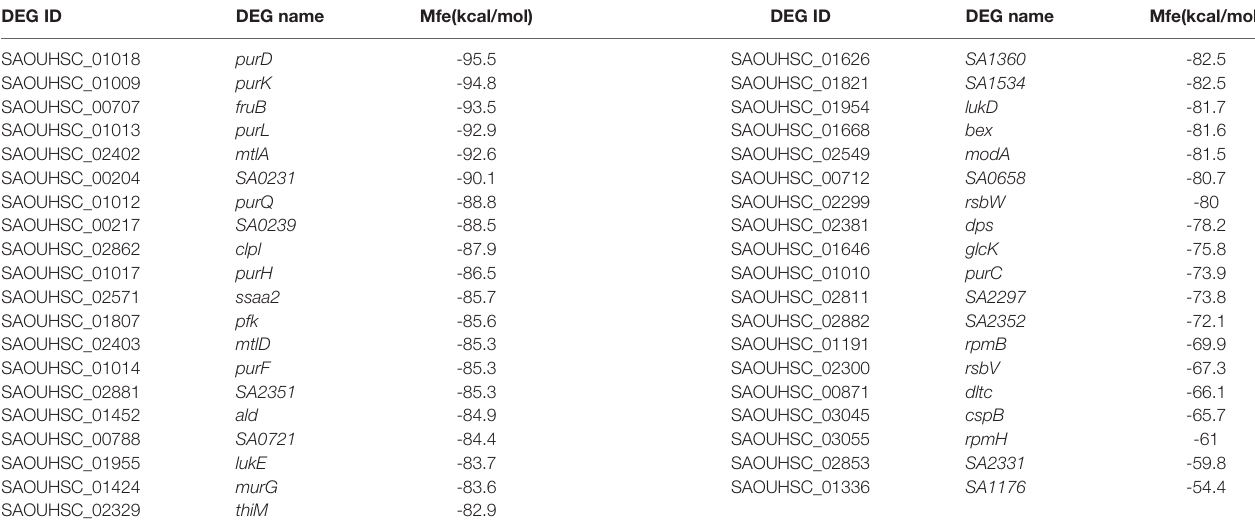
TABLE 3 | Molecular free energy (Mfe) obtained by SprC:mRNA of DEGs